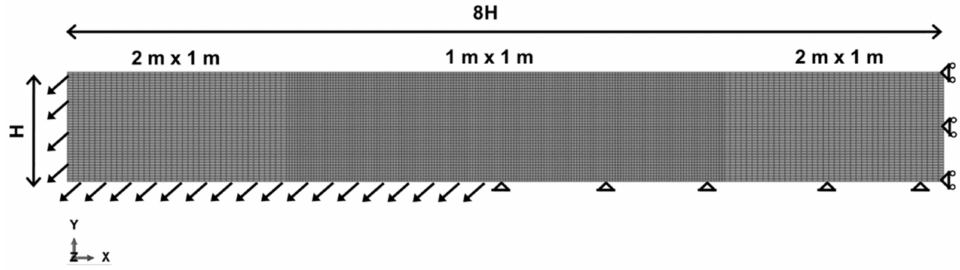
Figure 3. FE mesh, loading and boundary conditions for a 50 m-thick soil